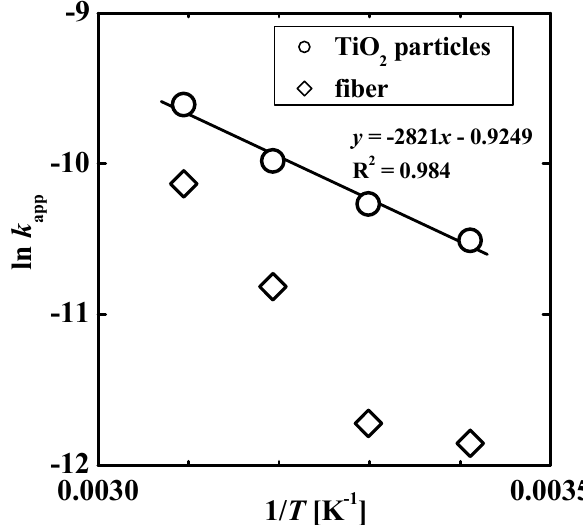
Figure 5. Arrhenius plot for the degradation of 4-isopropylphenol photocatalyzed by TiO 2 nanoparticles and the TiO 2 nanoparticle-loaded fiber.